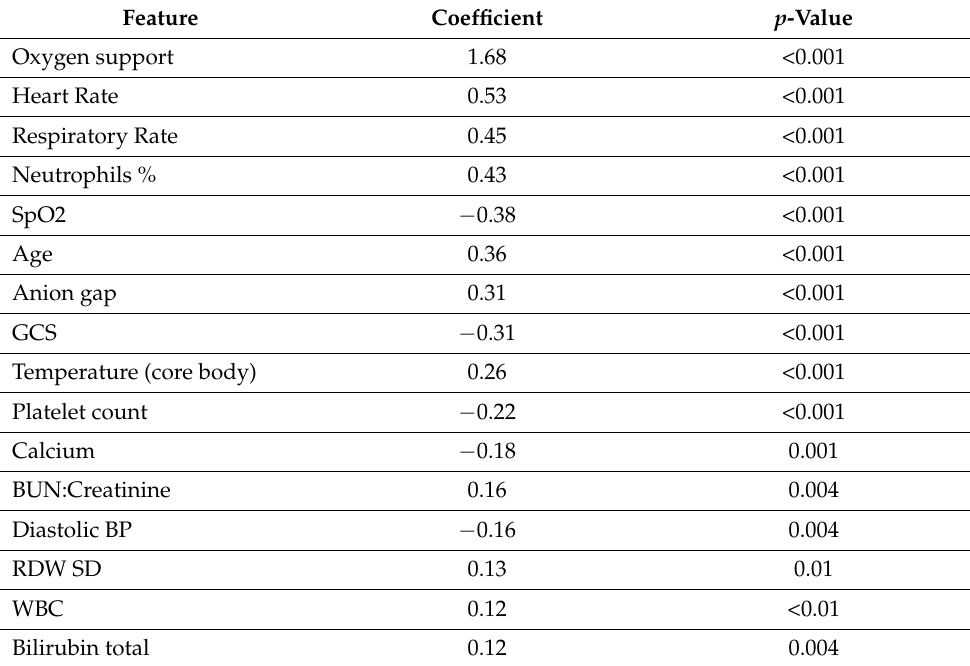
Table A5. Multivariate regression coefficients for comparison 3, 12 h prior to the event.